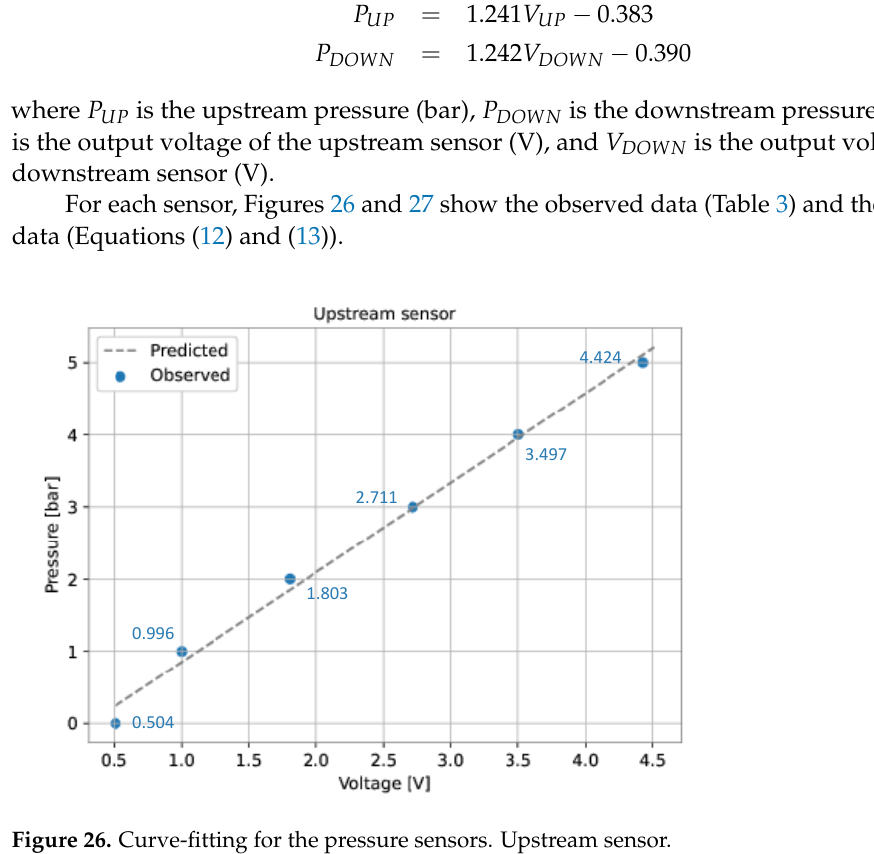
Figure 26. Curve-fitting for the pressure sensors. Upstream